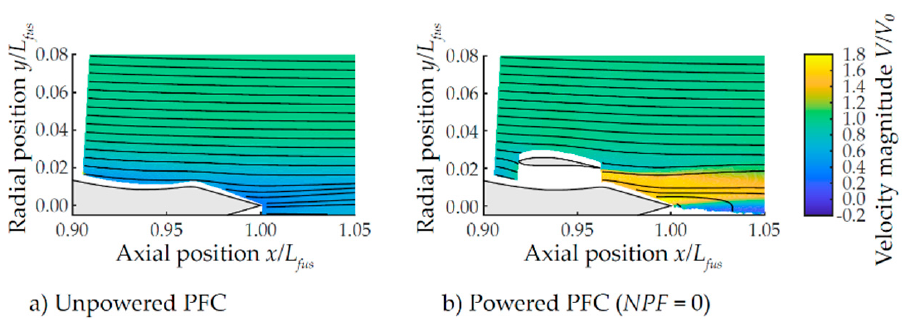
Figure 15. Time-averaged velocity field around the PFC aft-fuselage section of the 2D-PFC setup. Stereo-PIV measurements taken at V 0 = 20 m/s and NPF = 0.